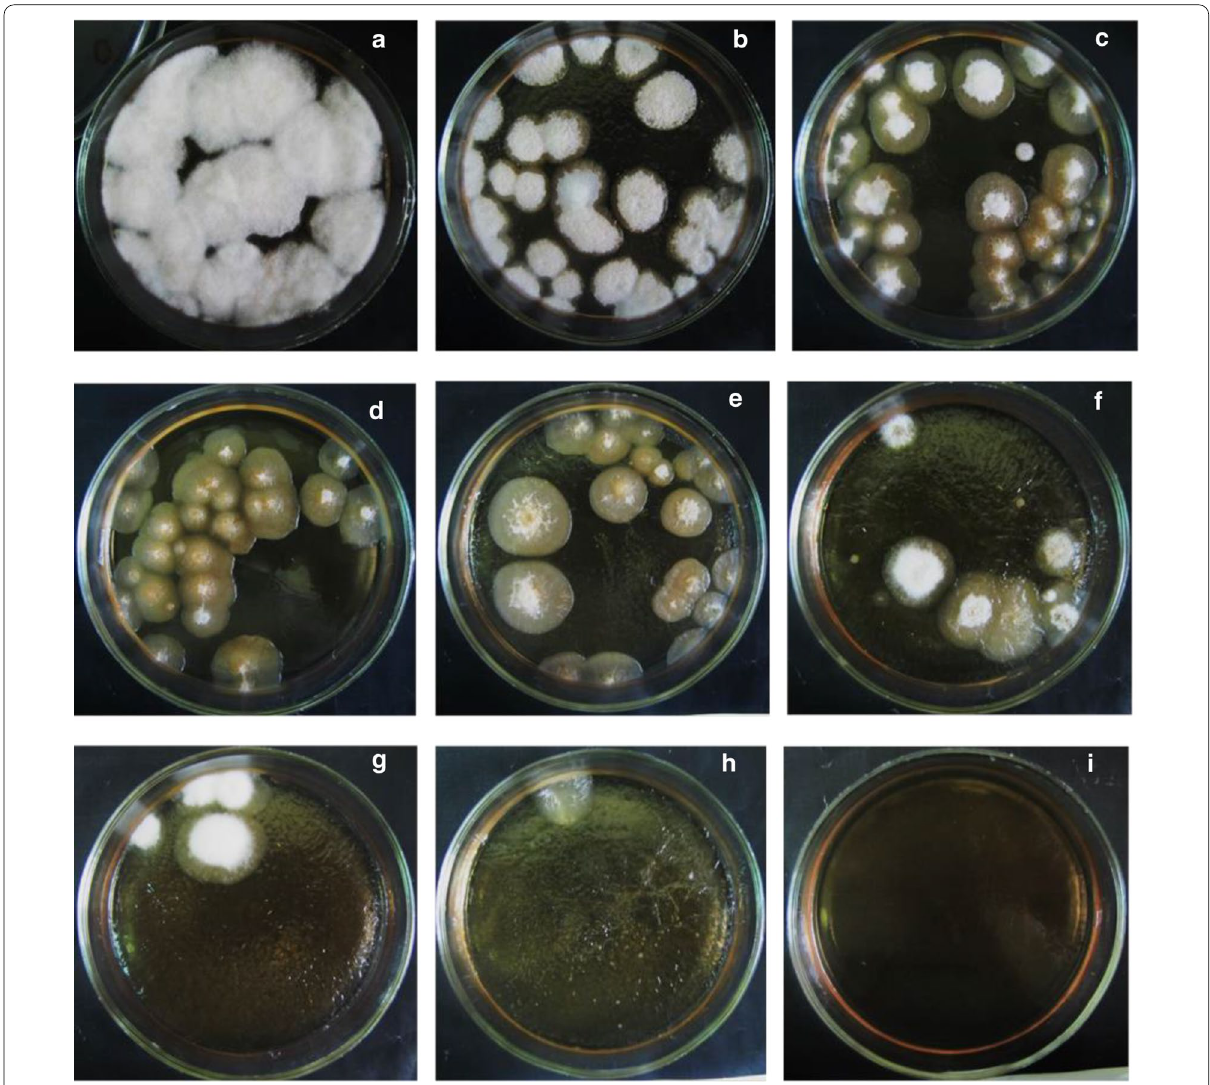
Fig. 5 The regenerative morphology of the colonies of G. zeae protoplasts. 10 µL of protoplast suspension (0.5 medium A supplemented with sucrose (1 M) and different concentrations of ketoconazole: 0 µM ( a ), 15 µM ( b ), 20 µM ( c ), 25 µM ( d ), 30 µM ( e